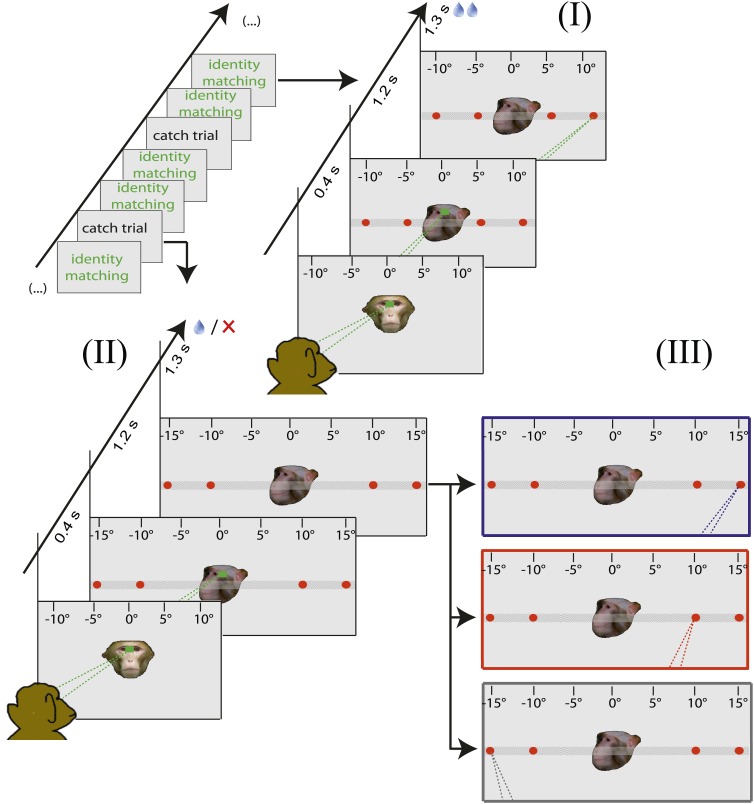
Design of the control experiment testing for associations between the facial identity and the ordinal position of targets.Again it was performed outside the MRI scanner in order to shed light on the strategies utilized to solve the identity matching task. Also here the observer was confronted with a sequence of normal identity matching trials (I) with occasional catch trials (II, 6–12% share). In catch trials the outer targets stayed in their standard locations of −10° and 10° respectively, whereas inner targets (normally at −5° and 5° respectively) were shifted further out to −15° and 15° eccentricity respectively. As a consequence of this shift, the 10° eccentricity targets maintained their standard spatial position but changed their ordinal position (from 1 and 4 to 2 and 3) (II). Again, the responses in catch trials later classified into three categories (III): (1) The 'learned order associations' strategy (target chosen according to its ordinal position in the target order with respect to a given demonstrator's identity, shifted from 10° to 15° on the cartoon, blue outline). (2) The 'learned absolute spatial associations' category (target chosen according to its absolute spatial position associated with a given demonstrator's identity, keeping his position at 10° on the cartoon, red outline), (3) The 'other' strategy.